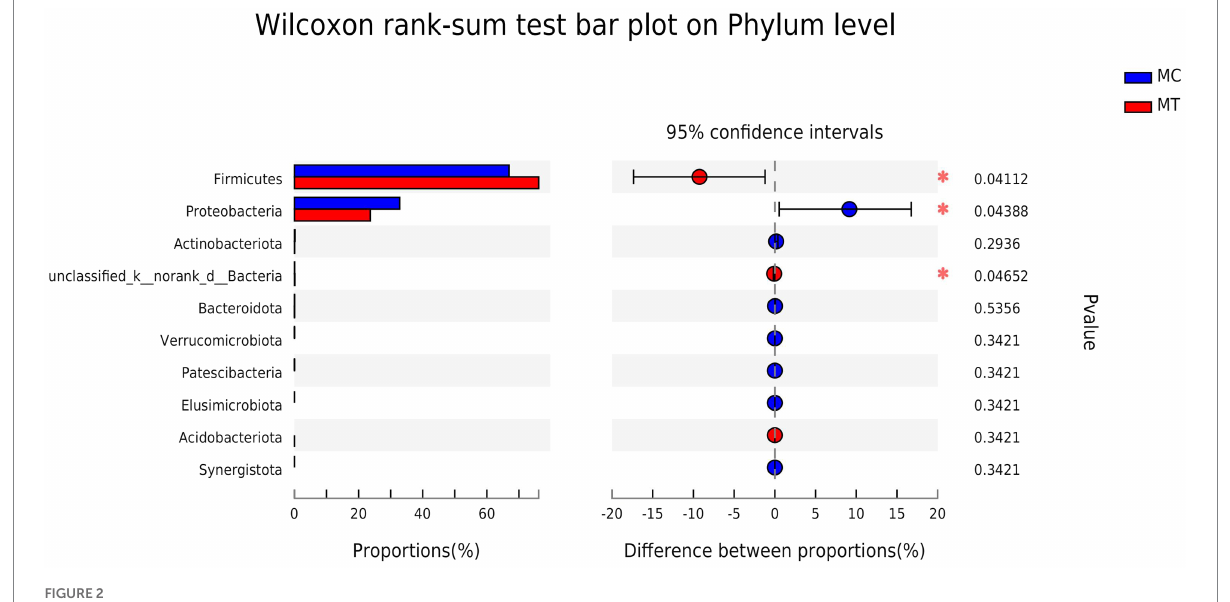
FIGURE 2 Difference analysis on Phylum level.